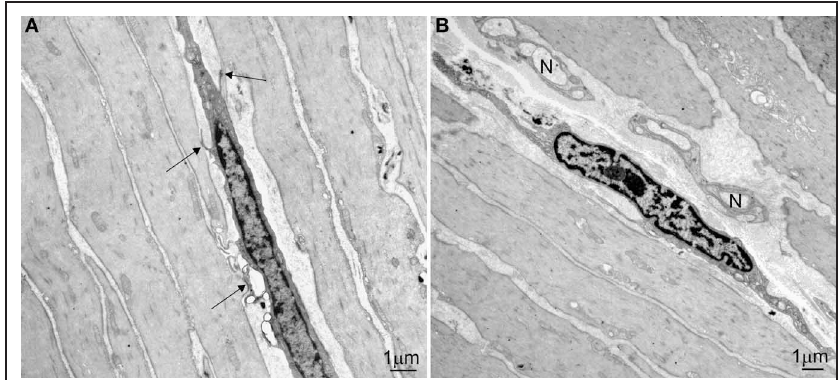
FIGURE 1 | Ultrastructure of ICC-IM in the circular muscle layer of the human lower esophagus. (A) An ICC-IM and its processes form multiple connections (arrows) with adjacent smooth muscle cells. (B) An ICC-IM in a small septum is close to two small nerve bundles